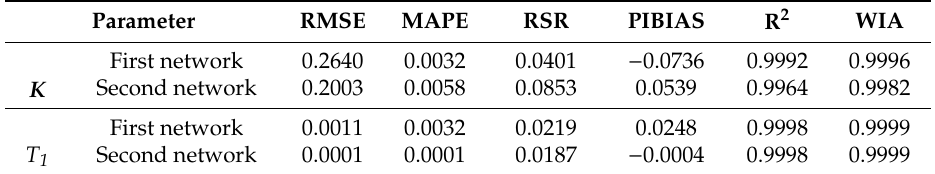
Table 5. Test datasets statistical performance indices (SPI) values of the developed PSO-ANFIS models for both